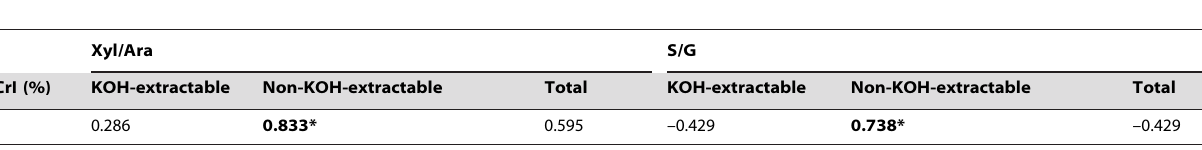
* Indicated significant difference at p , 0.05 (n=8).